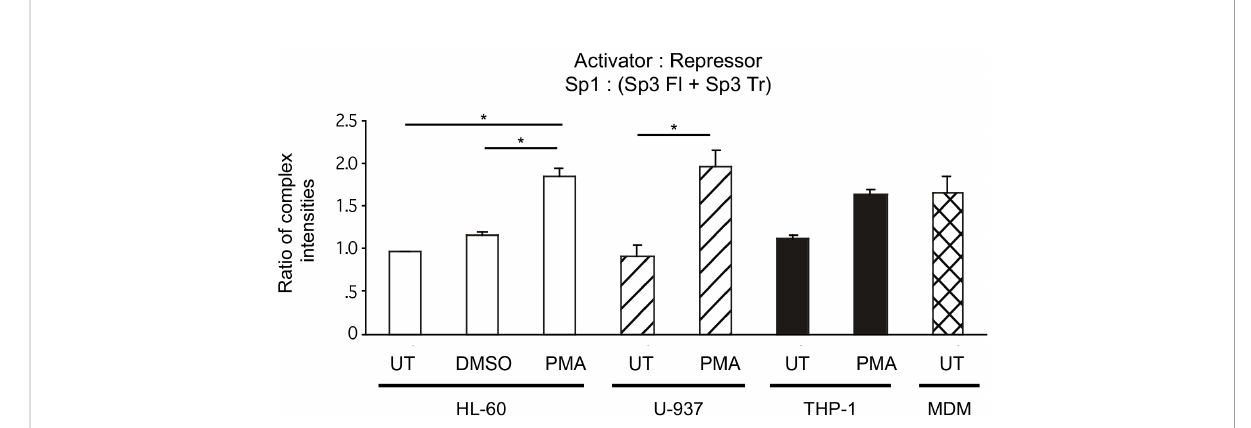
FIGURE 7 Comparisons of relative Sp family activator to repressor levels in untreated and chemically differentiated cell lines as well as primary MDM. To facilitate an examination of the effect of changing Sp factor binding on Sp-mediated activation of the HIV-1 LTR, results from Figures 3 – 6 have been coalesced to illustrate Sp1 (total activator) to the sum of both Sp3 isoforms (total repressor). Results from untreated and chemically differentiated cell lines are presented along with results from primary MDM. Statistical analysis between the three basal cells lines show no statistical difference. PMA treated cells cell lines were all statistically signi fi cantly higher than their basal comparator. Most important is that there was not a statistical difference between the PMA-treated cell lines and primary MDMs in this ratio. Comparisons between all were evaluated by the quantitative two-tailed student t-test and p < 0.05 was considered signi fi cant